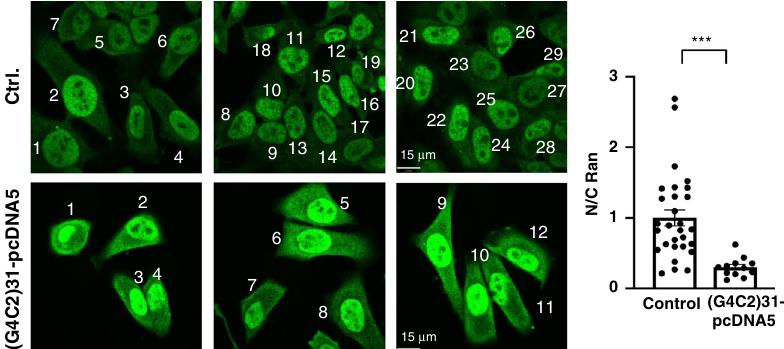
Fig. 5 (G4C2)31-RNA increases Ran accumulation in the cytosol of HeLa cells: imaging analyses. The (G 4 C 2 ) 31 -pcDNA5 or empty vector (Ctrl.) was transiently transfected into HeLa cells. Distribution of endogenous ras-related nuclear protein (Ran; Green) was detected by immunostaining and confocal microscopy. The semi-quanti fi cation of cytosolic or nuclear Ran was performed by using NIH Image J. (version 1.51b; right panel). Data are presented as means ± SEM for control cells ( n = 29) and for cells ( n = 12) overexpressing (G 4 C 2 ) 31 -RNA. Two-tailed unpaired Student ’ s t test, p = 0.0003, *** p < 0.001. Ran: ras-related nuclear protein. n = 3 independent experiments with similar results from biologically independent